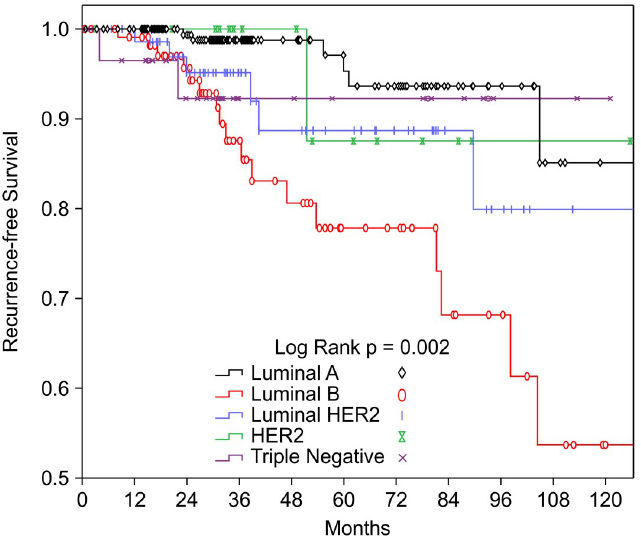
Fig 3. Kaplan–Meier curves of recurrence-free survival according to lymph node status and breast cancer subtype. HER2, human epidermal growth factor receptor 2.